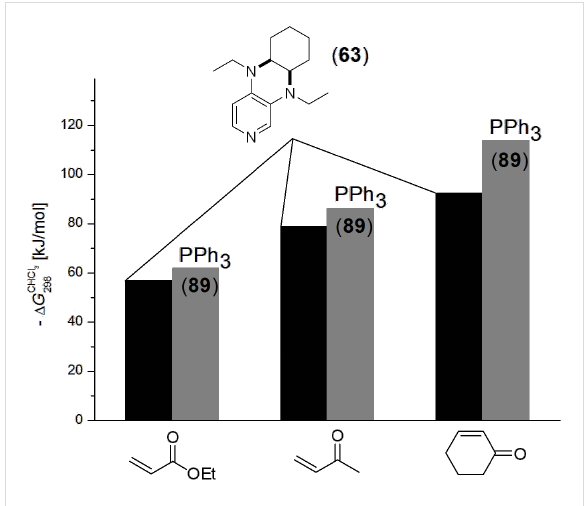
Figure 12: Inverted reaction free energies for the addition of N- and P-based Lewis bases to three different Michael acceptors.